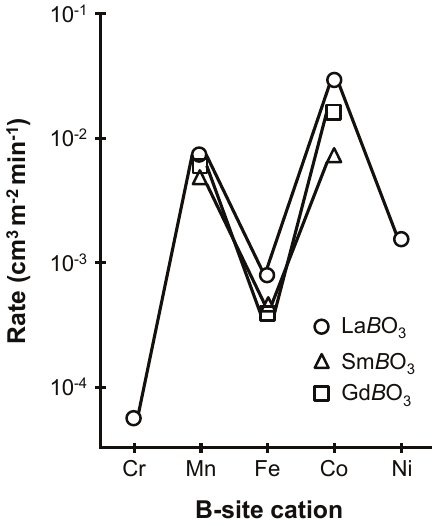
Figure 1. Influence of A- and B-site cations on the catalytic activity of perovskite-type oxides for propane oxidation at 227 °C (Remark: B in La B O the B-site metal cation and not to boron element). Adapted with permission